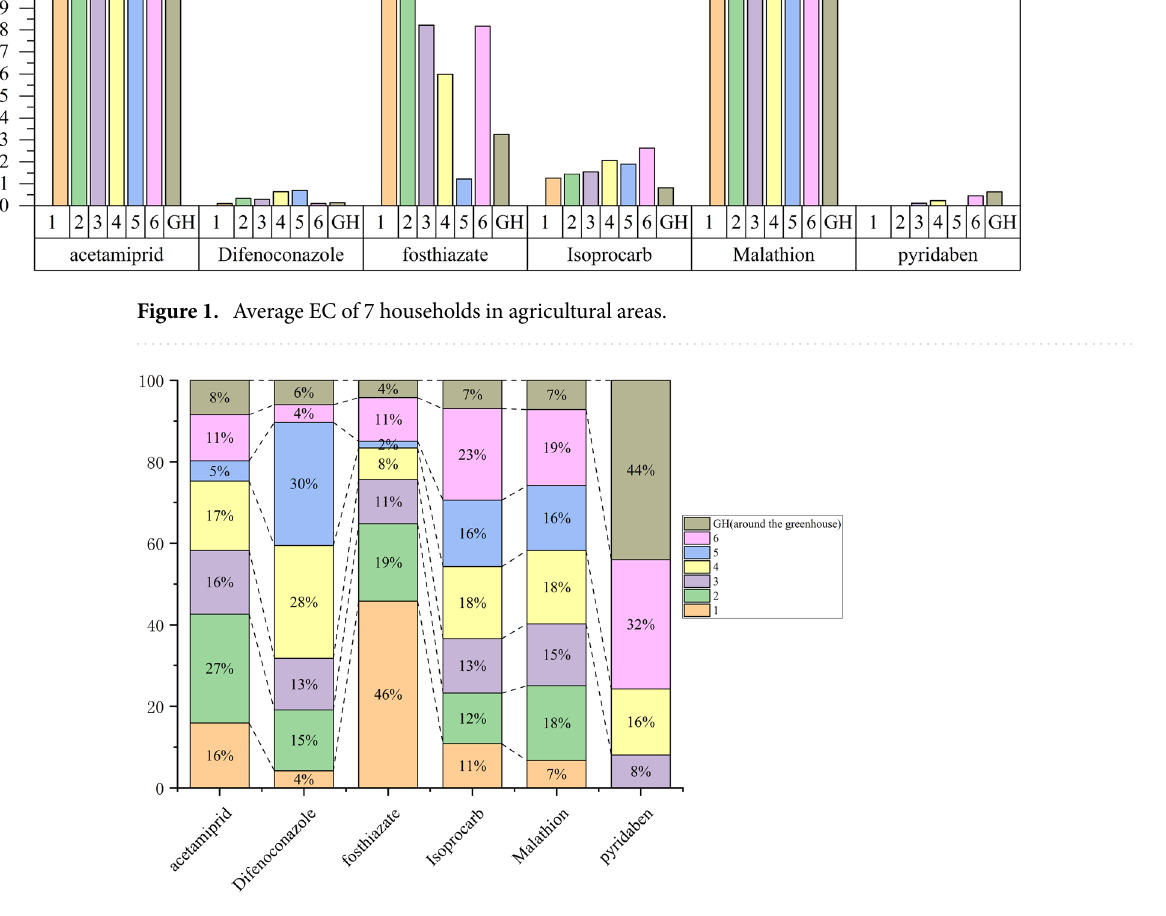
Figure 2. Average EC percentage per household for each